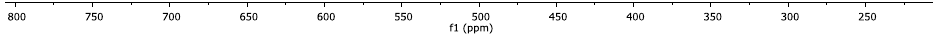
Figure 1. 77 Se{ 1 H} NMR experiments of Se(CN) 2 (red), Se 2 (CN) 2. (green) and Se 3 (CN) 2 (blue) in DMSO-d 6 . in DMSO-d 6